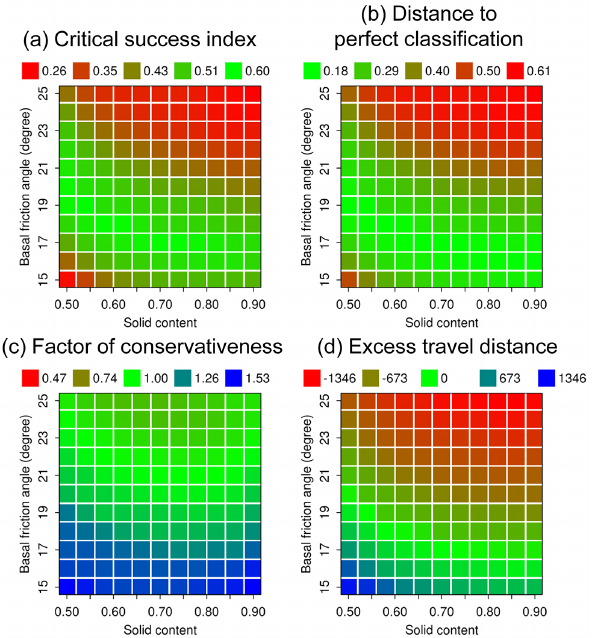
Figure 11. Validation and optimization of DII for the Acheron rock avalanche (see Table 4 for the criteria): (a) critical success index (CSI); (b) distance to perfect classification (D2PC); (c) factor of conservativeness (FoC); (d) excess travel distance ( (cid:49)L ).